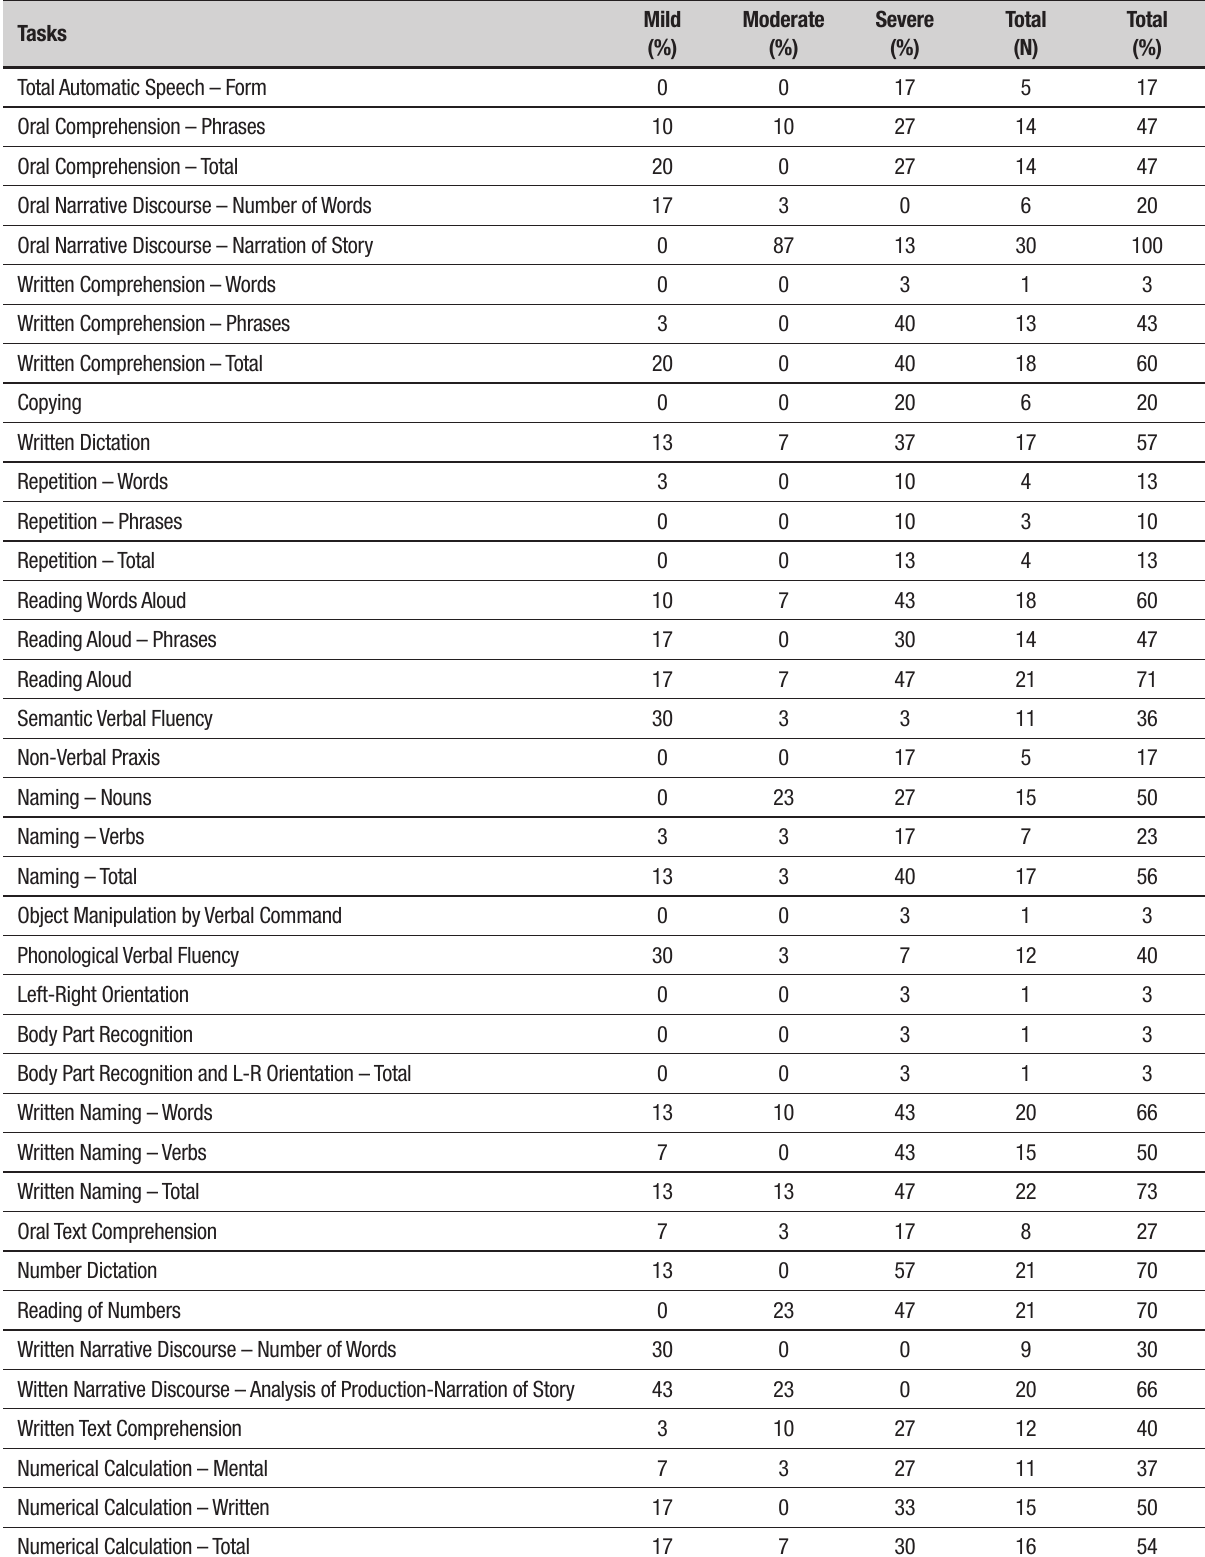
Table 2. Percentage of healthy low-educated (2-4 years education) individuals whose performance indicated impairment based on Z-score calculation, using normative data for a population with 5-8 years education as a reference. Language tasks that showed differences between groups with 1-4 and 5-8 years